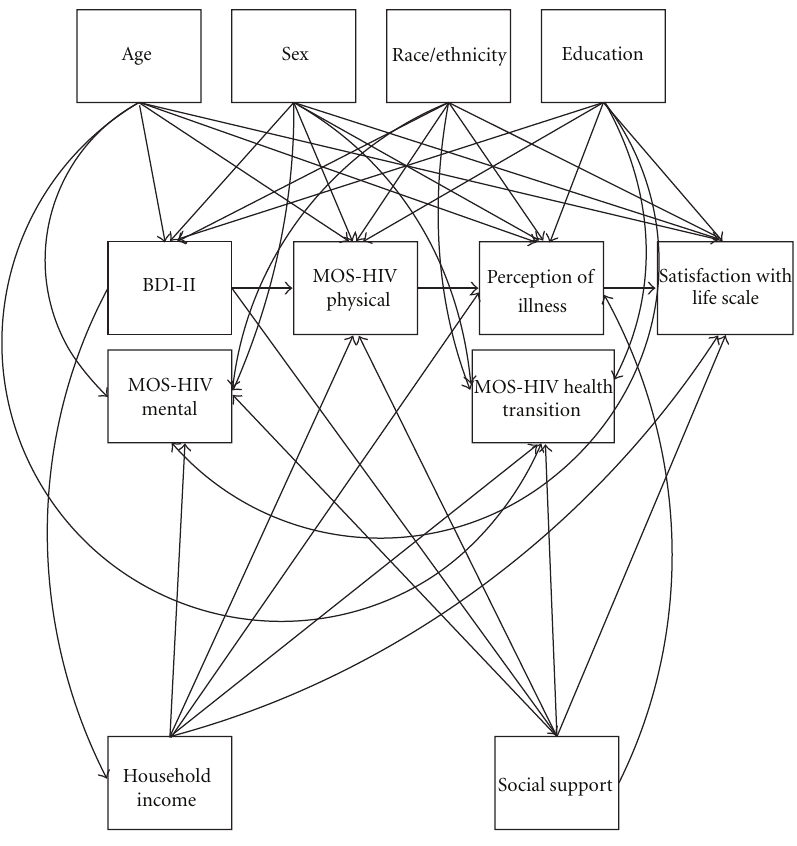
Figure 2: Additional 36 covariate relationships tested in exploratory